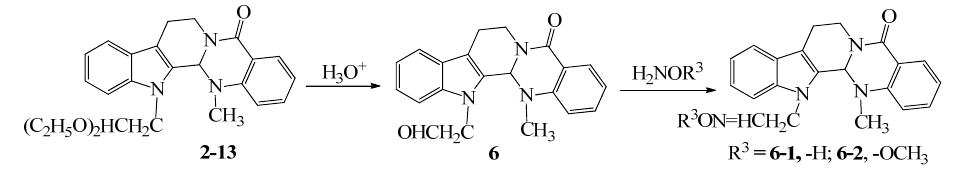
Scheme 4. Synthesis of 6 , 6-1 – 6-2